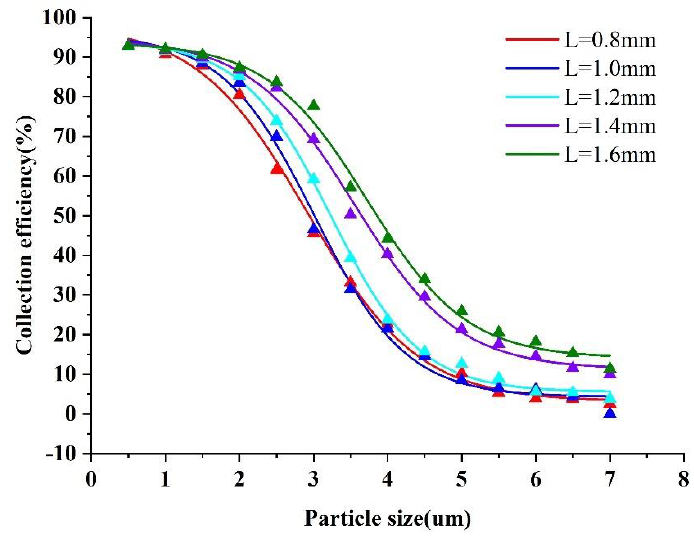
Figure 7. Collection efficiency curves at different L values.